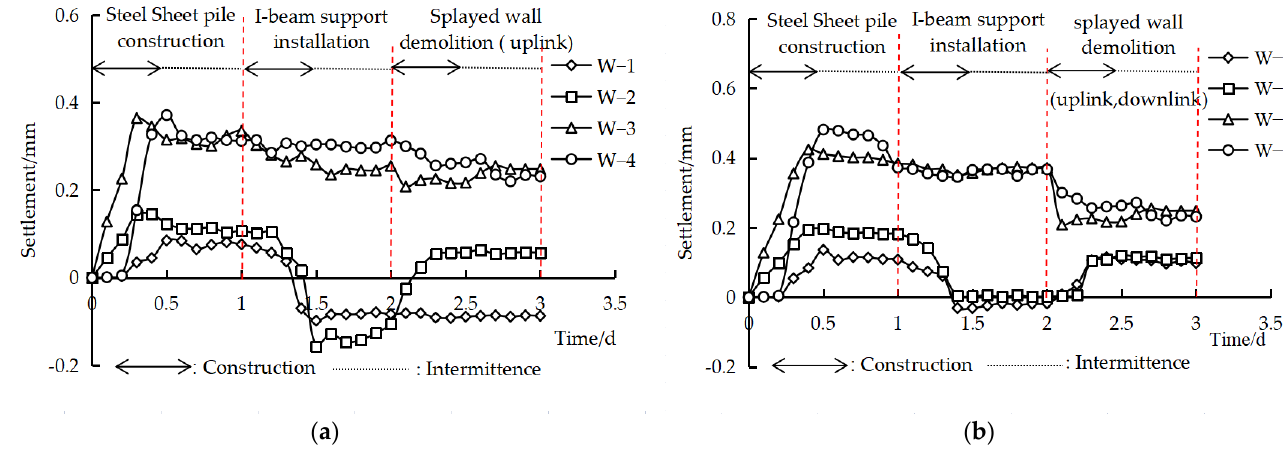
Figure 9. Relation curve of level gauge deformation with the implementation time of the scheme: ( a ) Site 1; ( b ) Site 2.